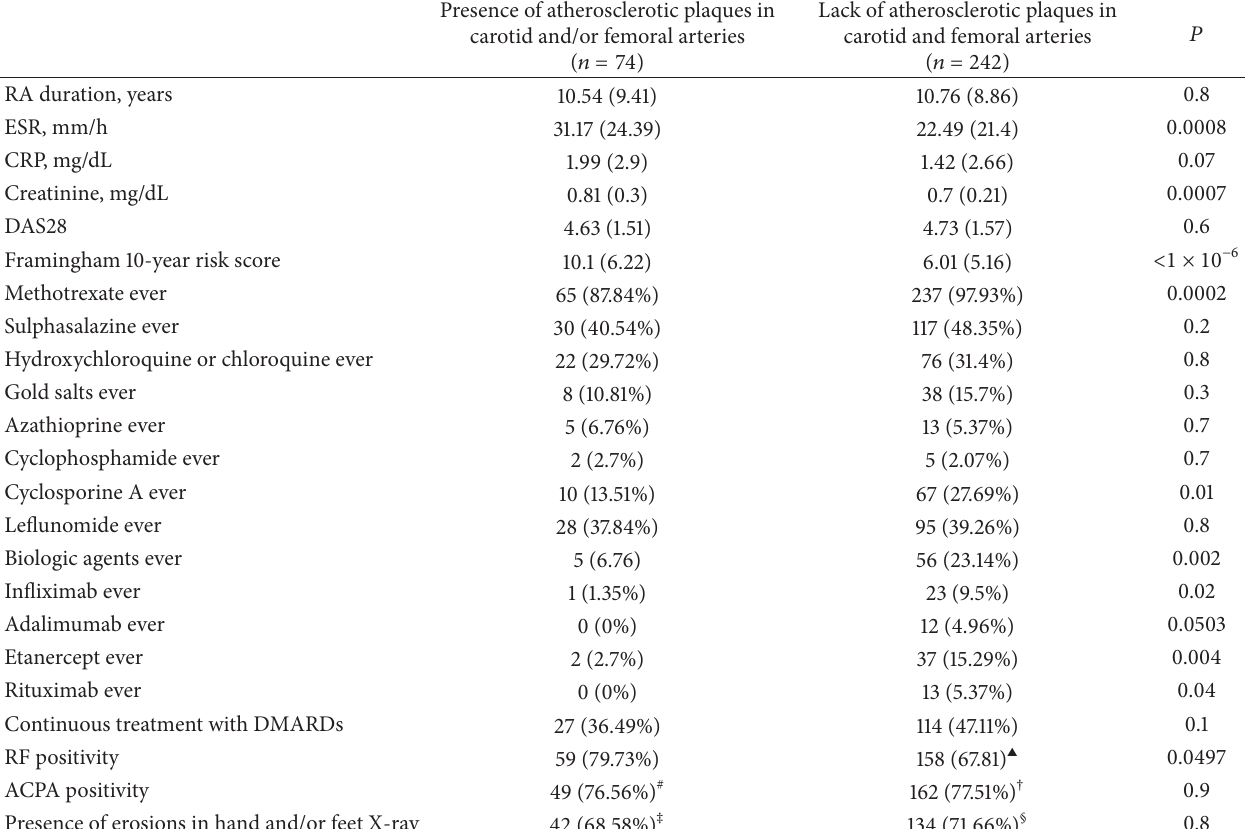
Table 2: Associations between presence of atherosclerotic plaques and clinical, laboratory, and radiological characteristics and use of different